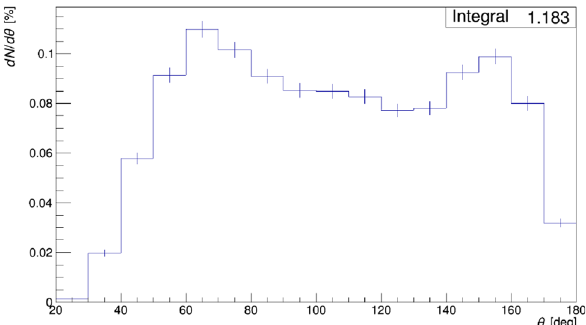
Fig. 23 Detection efficiency distribution as a function of the correla- tion angle between e + and e − for detector placed at angles 0 ◦ , 60 ◦ , 120 ◦ , 180 ◦ and 270 ◦